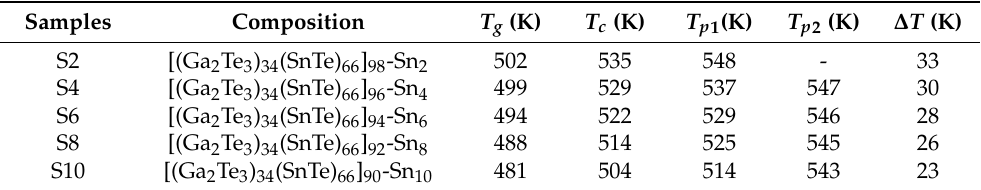
Figure 2. ( a ) Heat flow traces of the melt-spun [(Ga 2 Te 3 ) 34 (SnTe) 66 ] 100-x -Sn x samples ( x = 2, 4, 6, 8 and 10%) and ( b ) composition dependence of the glass transition temperature T g (Green triangle), the crystallization onset temperature T c (Red square) and the supercooled liquid region ∆ T (Blue circle). Table 1. The characteristic temperatures T g , T c , T p 1 , T p 2 and Δ T for the [(Ga 2 Te 3 ) 34 (SnTe) 66 ] 100-x -Sn x amorphous samples ( x = 2, 4, 6, 8 and 10).